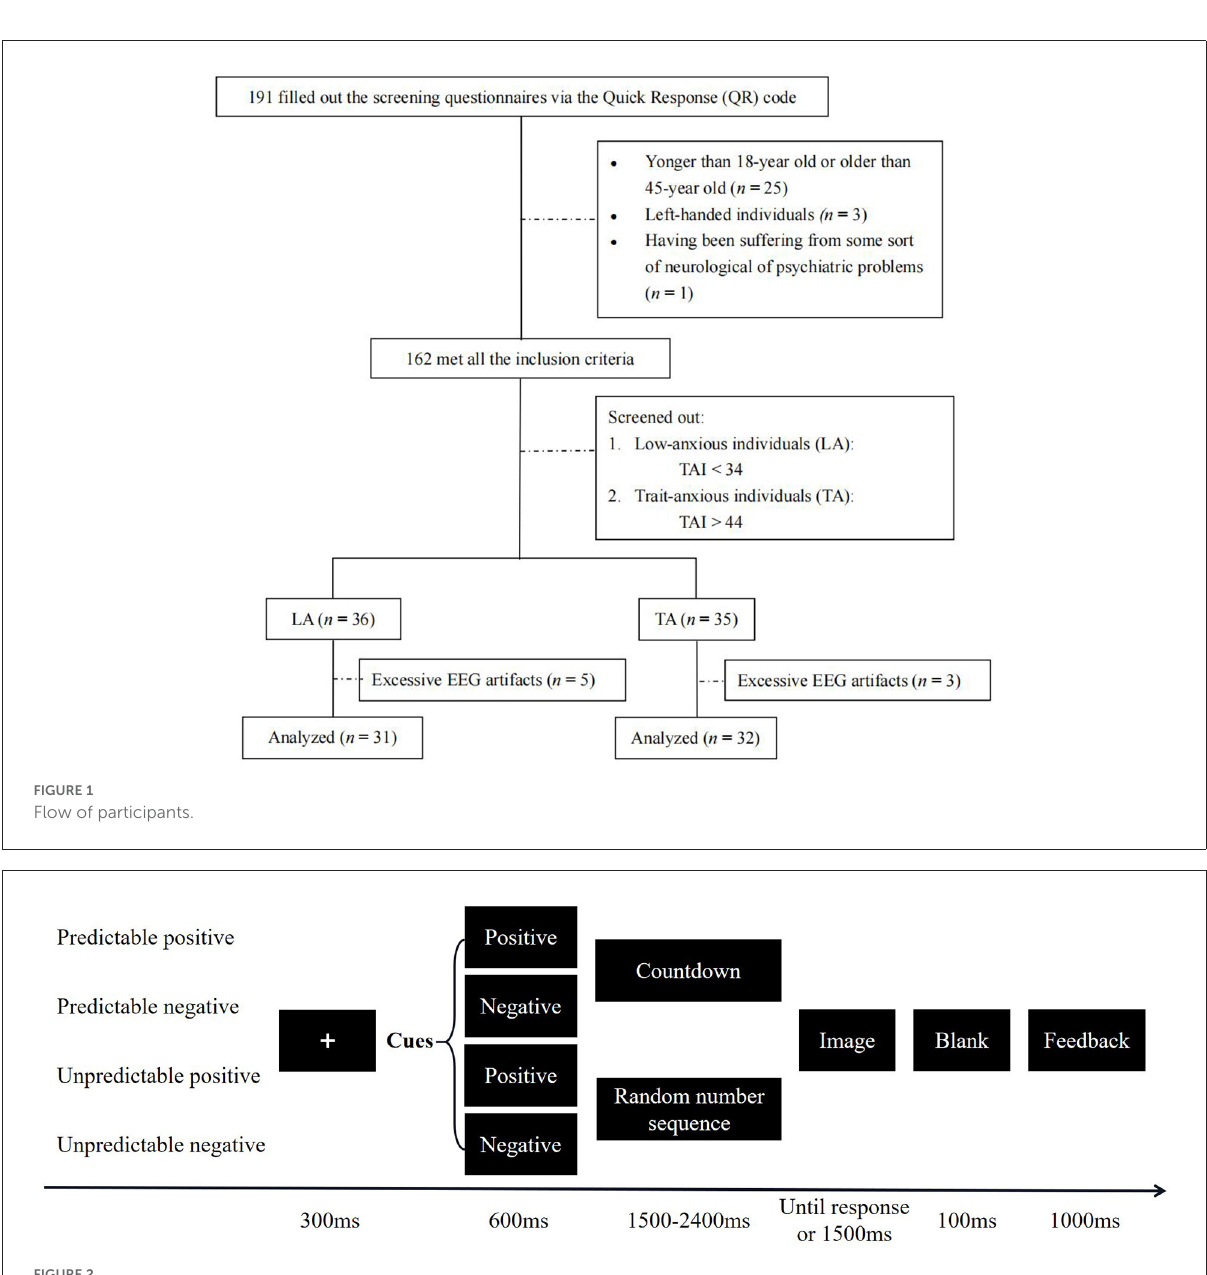
FIGURE2 Schematic of experimental